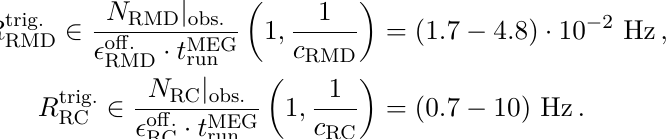
resolution. Left: missing mass /E